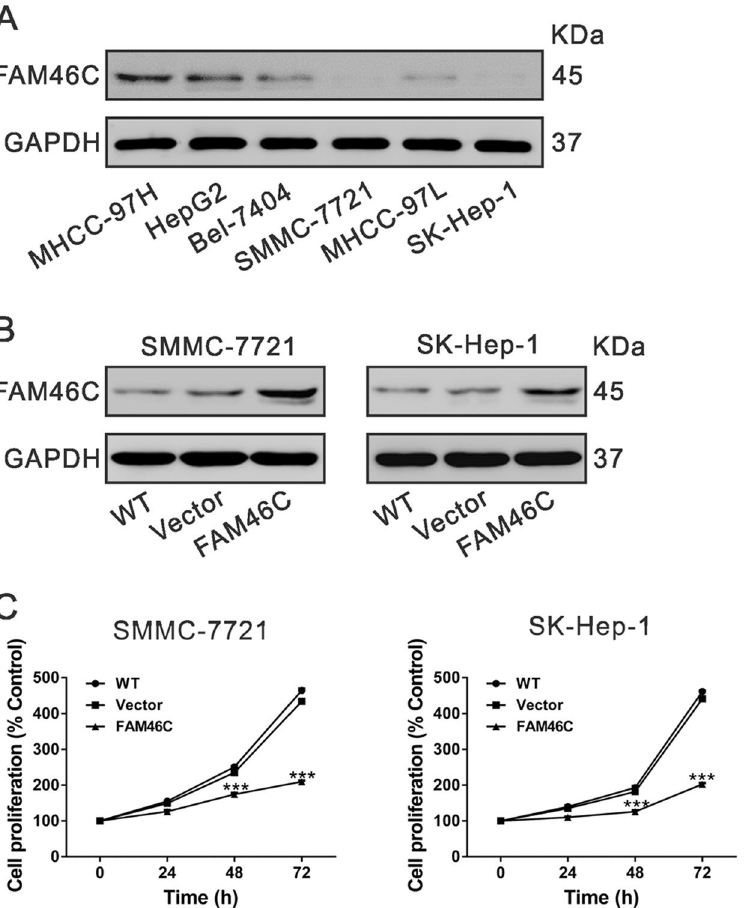
Figure 4. FAM46C overexpression inhibited HCC cell proliferation. ( A ) Expression of FAM46C in 6 HCC cell lines as determined by Western blotting. ( B ) Ectopic expression of FAM46C in SMCC-7721 and SK-Hep-1 cells was examined by Western blotting. ( C ) Ectopic expression of FAM46C significantly decreased cell proliferation as determined by CCK-8 assay. All experiments shown were performed independently at least three times. *** P < 0.001 as compared with Vector virus-infected